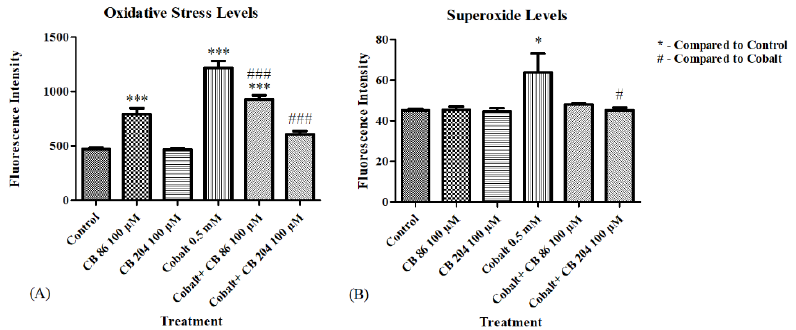
Figure 4. The protective effect of the TSPO ligands in prevention of reactive oxygen species (ROS) elevation. ELISA was performed to evaluate the levels of oxidative stress and superoxide levels. ( A ) Represents the oxidative stress levels, and ( B ) Represents the superoxide levels, with and without pretreatment with TSPO ligands. Results are expressed as mean ± SEM ( n = 6 replicates in each group). # and * p < 0.05, ### and *** p < 0.001.